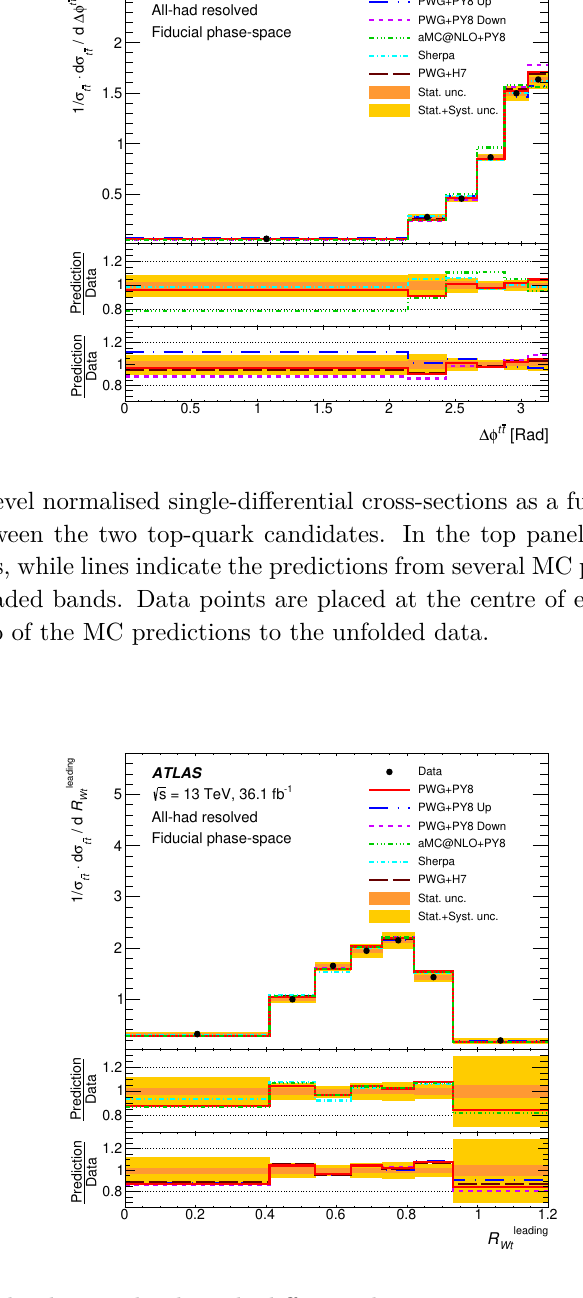
Figure 10 . Particle-level normalised single-differential cross-section as a function of the ratio of the W -boson p to its parent top-quark p for the leading top quark, R leading . In the top panel, T T Wt the unfolded data are shown as black points, while lines indicate the predictions from several MC programs. Uncertainties are shown by the shaded bands. Data points are placed at the centre of each bin. The lower two panels show the ratio of the MC predictions to the unfolded